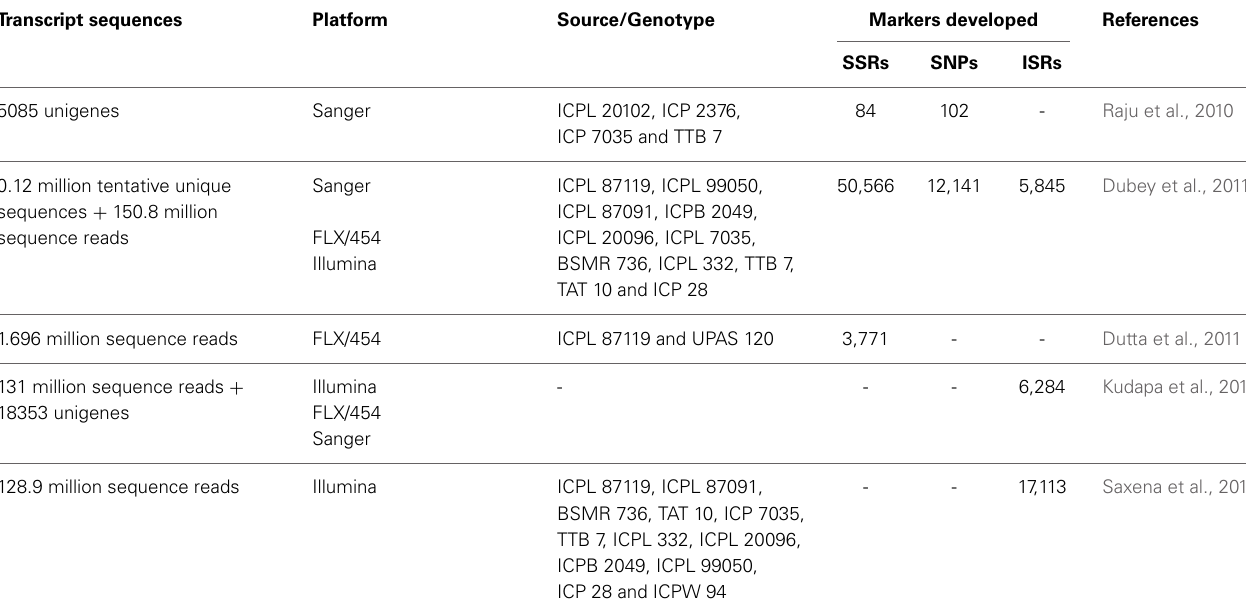
Table 3 | Genomic resources generated through transcriptome sequencing in